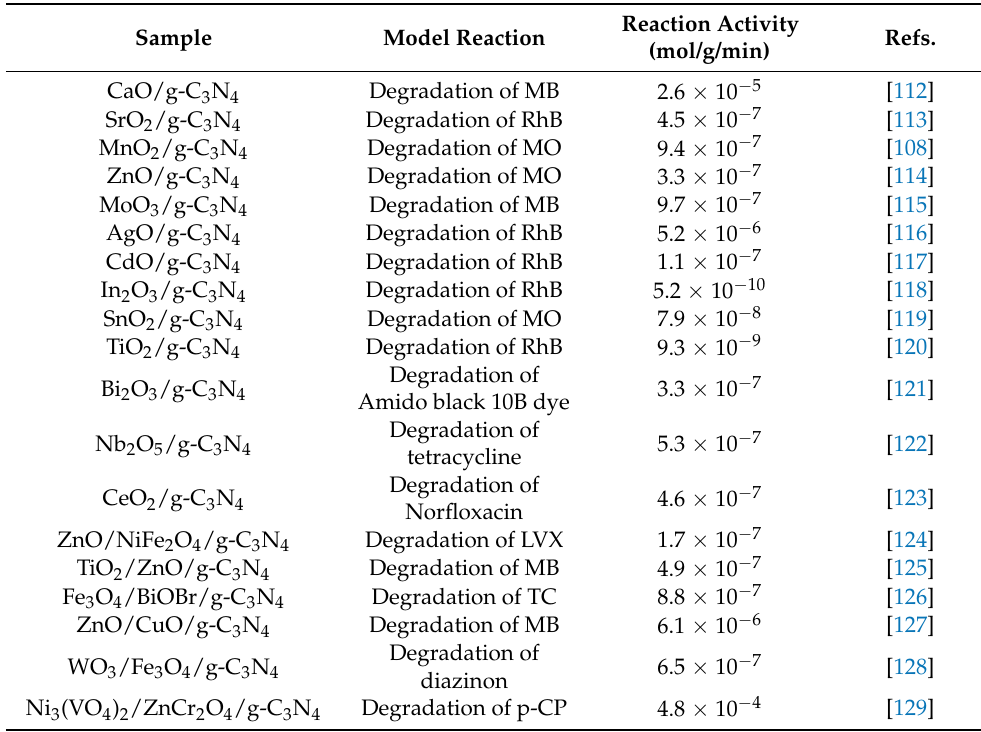
Table 2. Summary of recent advances in photocatalytic degradation using metal oxide/g-C 3 N 4 composites.